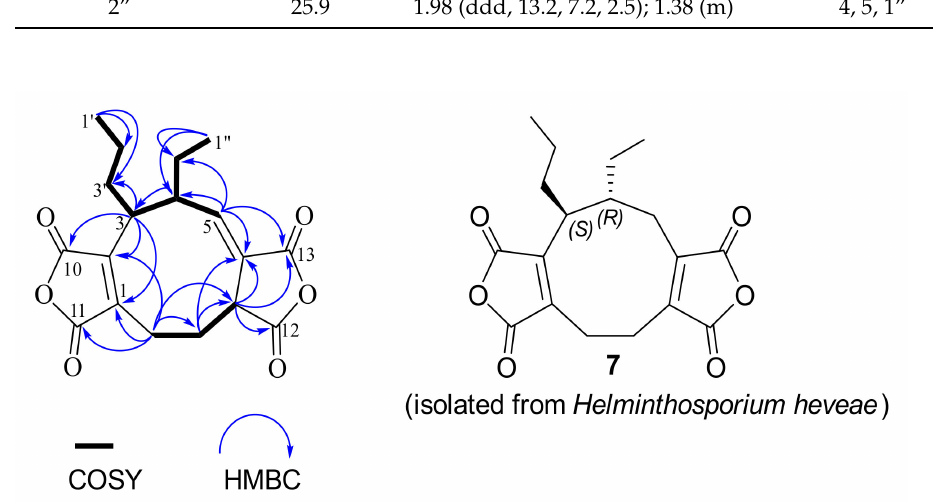
Figure 2. COSY ( 1 H— 1 H) and selected HMBC ( 1 H → 13 C) correlations of